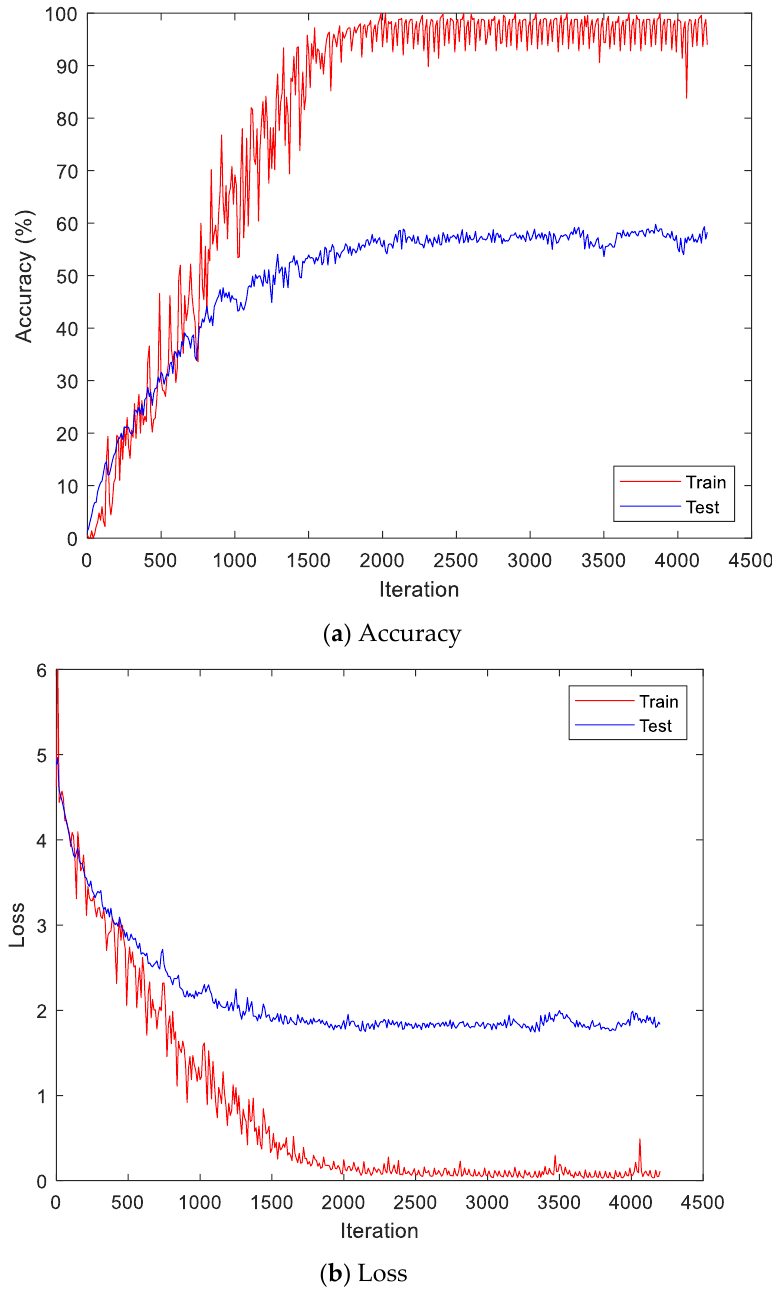
Figure 14. Training process by the feature extraction and LSTM-based individual identification model (CU-EMG-ECG dataset).